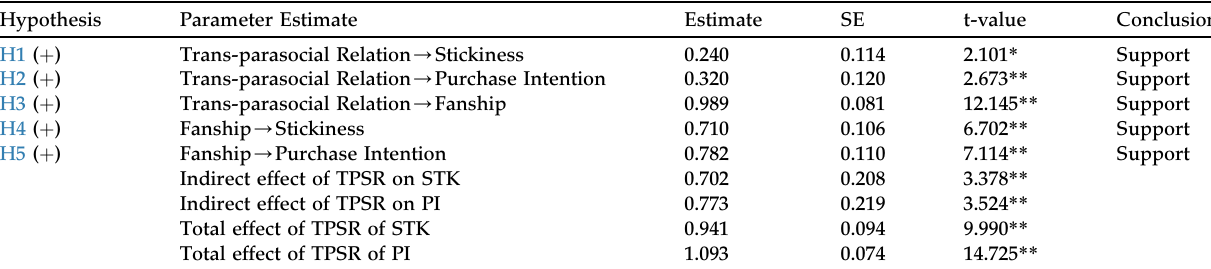
Table 4. Structural parameter estimates.